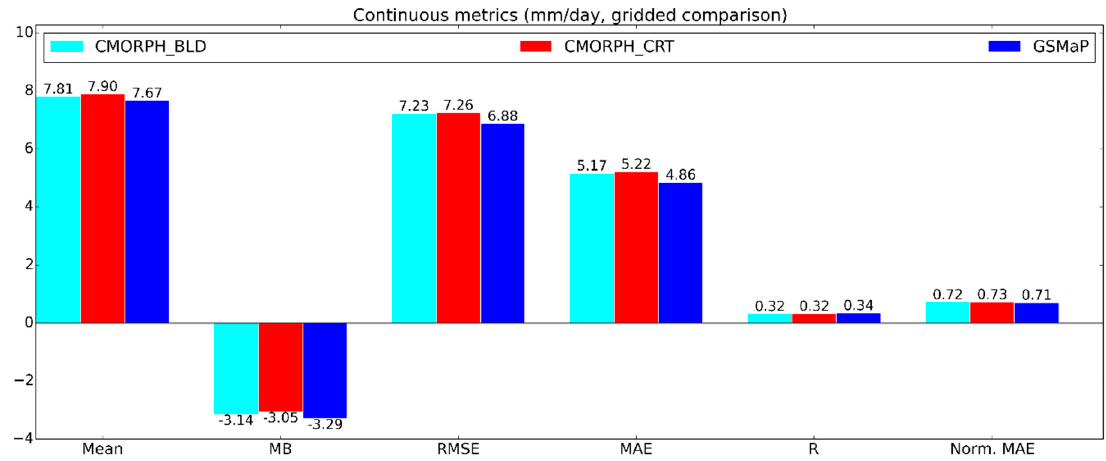
Figure 3. Gridded continuous comparison of satellite datasets against ERA5 from January 2001 to December 2018. Mean rainfall, mean bias (MB), root-mean-square error (RMSE), mean average error (MAE), Pearson correlation coefficient (R), and normalised mean average error (norm. MAE) are displayed.